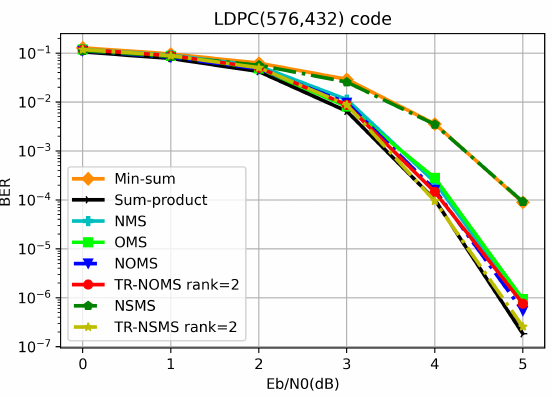
Figure 10. BER performance of TR-NOMS, TR-NSMS, NOMS [22] and NSMS algorithms for LDPC(576,432) code.